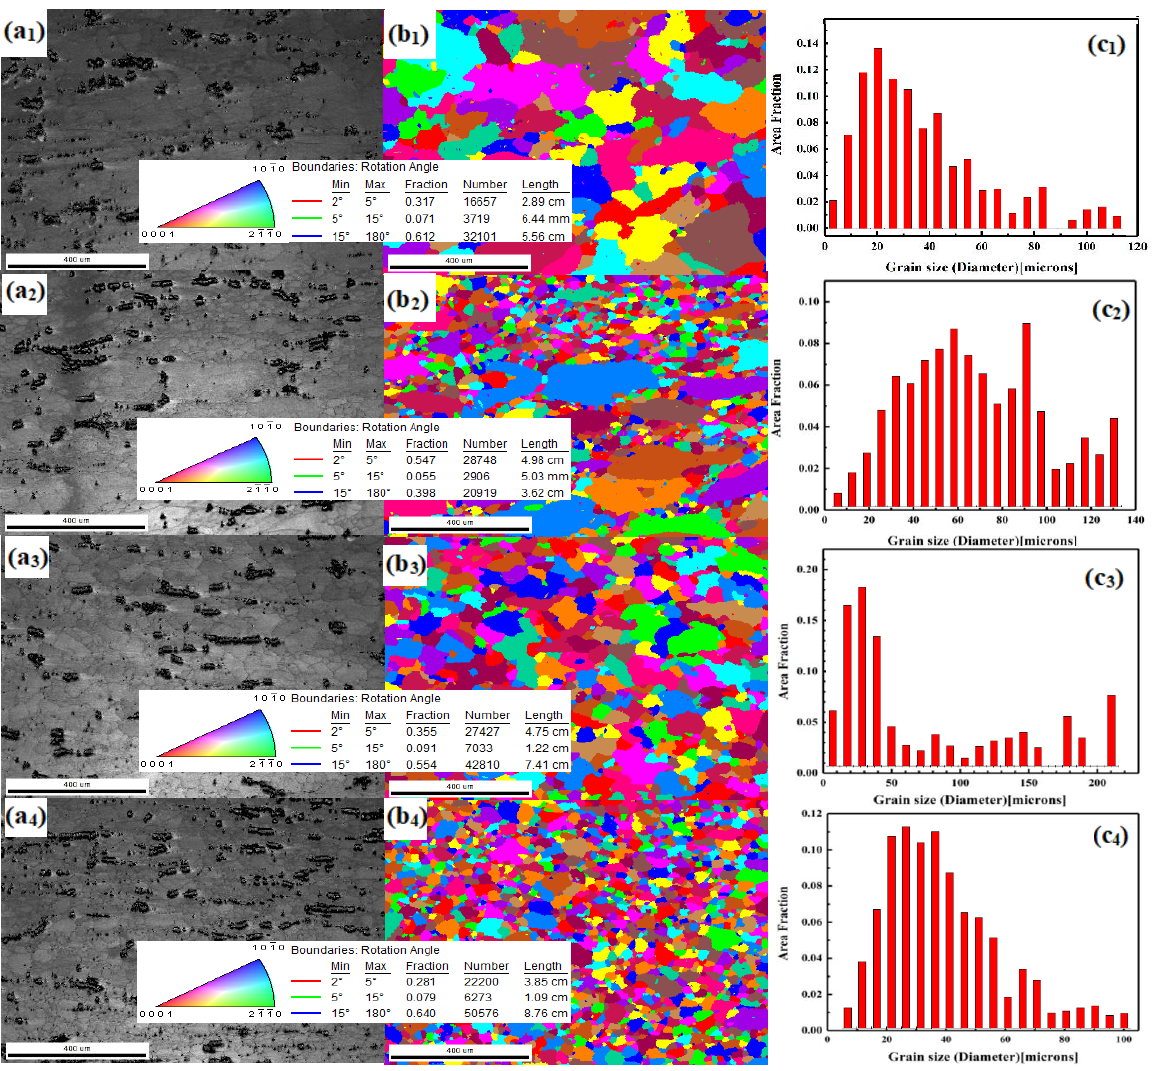
Figure 9. EBSD images of the alloy during hot compression at 733 K. ( a 1 – a 4 ) are the original images at 0.001, 0.01, 0.1, and 1 s − 1 , respectively; ( b 1 – b 4 ) orientation imaging at 0.001, 0.01, 0.1, and 1 s − 1 , respectively; ( c 1 – c 4 ) grain statistics at 0.001, 0.01, 0.1, and 1 s − 1 , respectively.